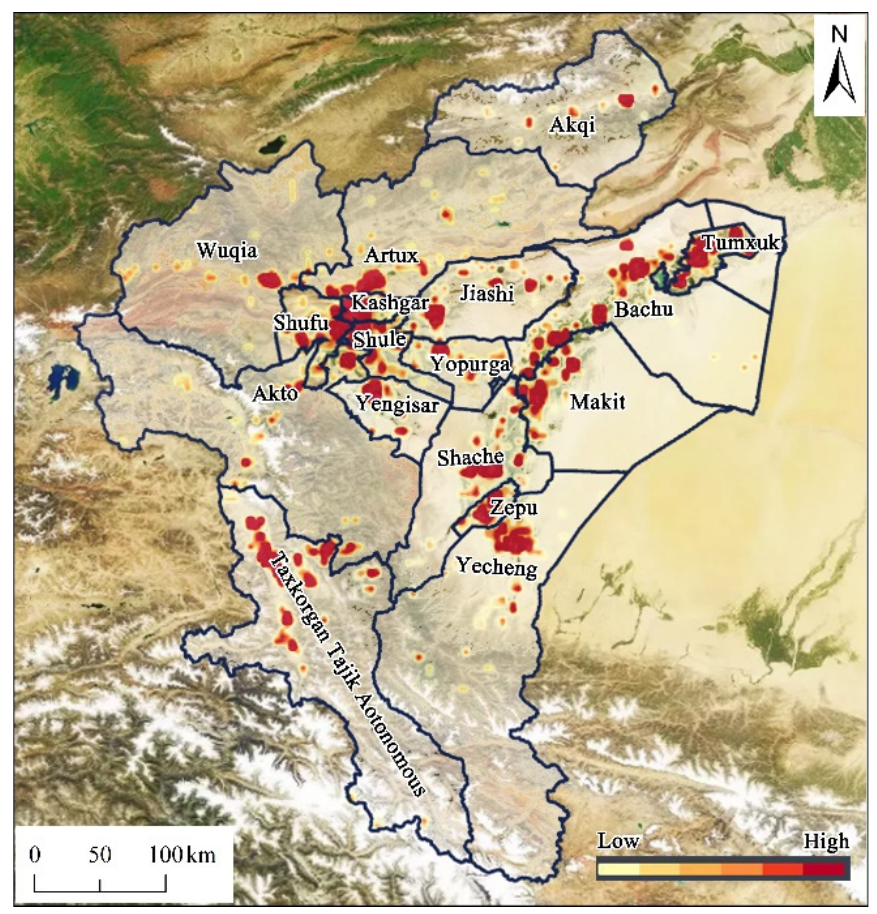
Figure 12. All types of POI density hot spot maps.